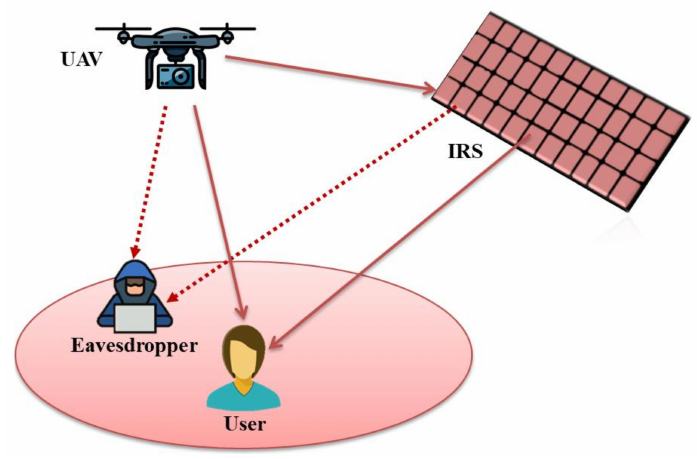
Figure 3. IRS-assisted UAV communication in the presence of eavesdropper. Table 2. IRS-assisted UAV communication